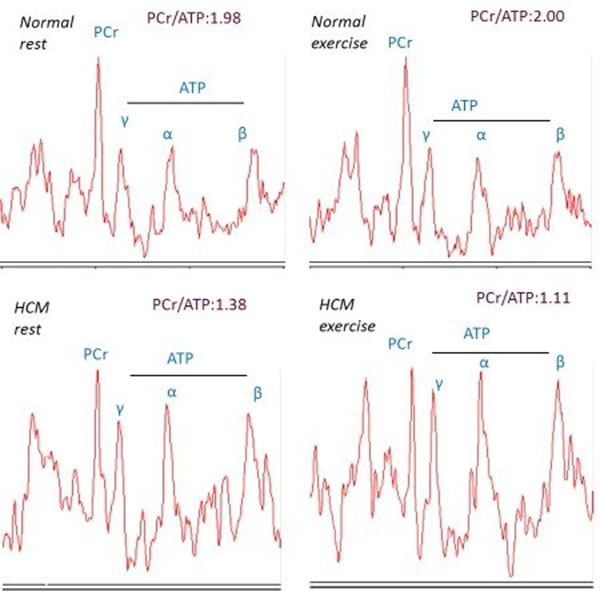
Examples of rest and exercise energetics in normal and HCM.